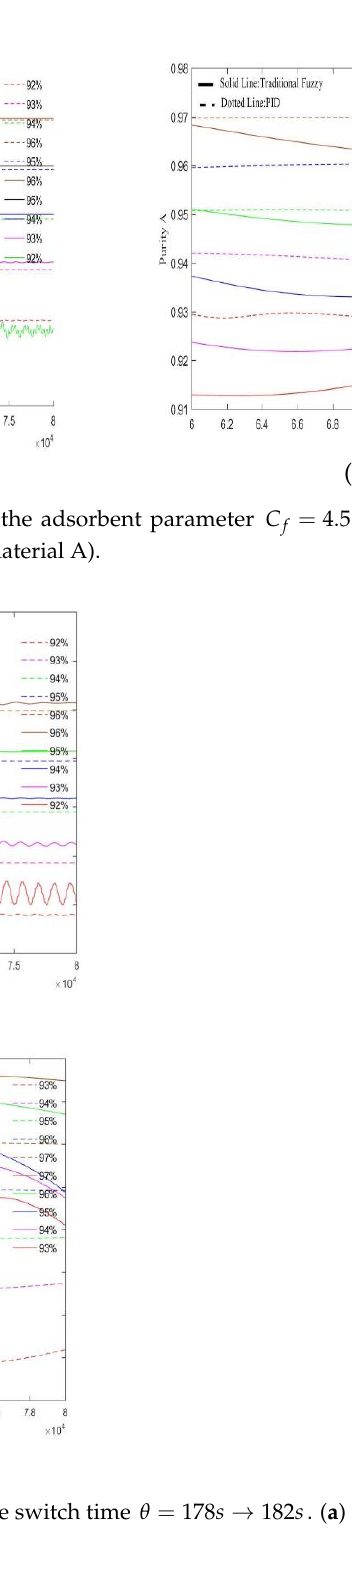
Figure 17. Under the change of the adsorbent parameter